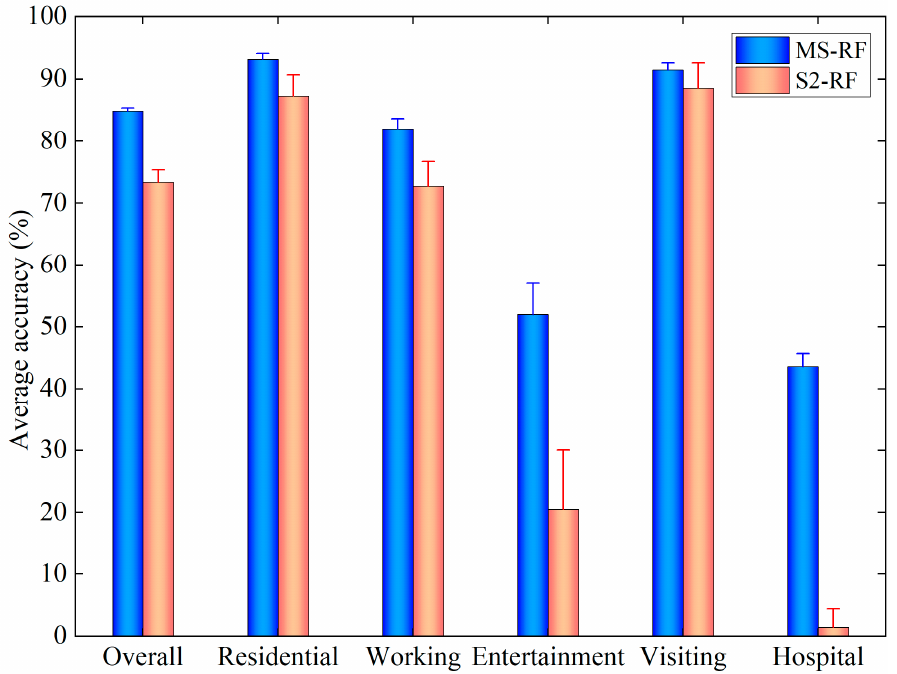
Figure 15. Average and standard deviation of the classification accuracy of the MS-RF model and S2-RF model for ten independent experiments.